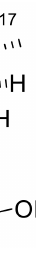
Figure 3. The structure of ingenol mebutate. Table 1. IC 50 values ( µ M ± SD) of the ingol- and ingenane-type diterpenoids ( 1 – 9 ).